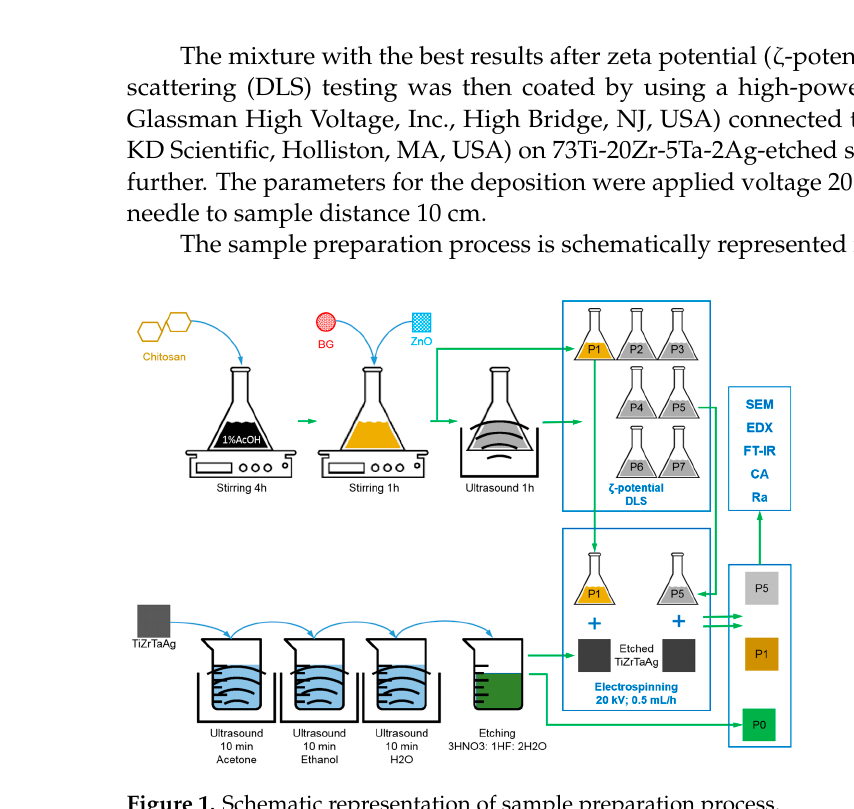
Table 1. List of fabricated samples and components .